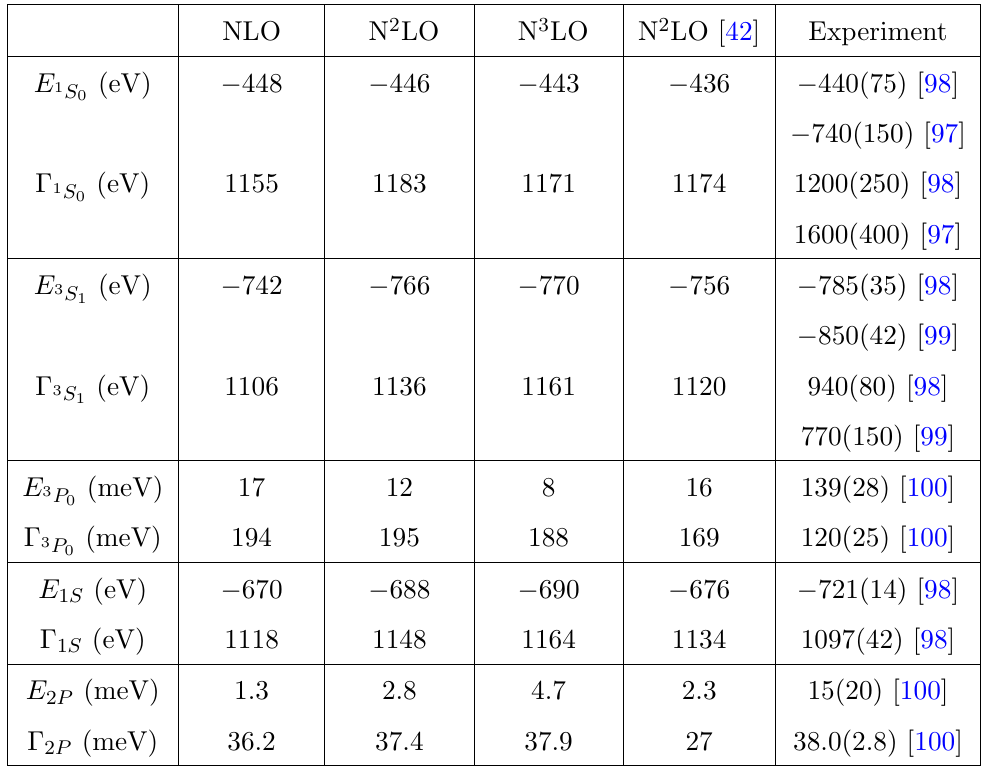
Table 4 . Hadronic shifts and broadenings in hyper(cid:12)ne states of (cid:22) p H for the chiral potentials with R = 0 : 9 fm. For comparison N 2 LO predictions of our previous chiral potential are included, based on the cuto(cid:11) combination ((cid:3), ~(cid:3)) = (450,500) MeV [42]. The experimental information is taken from refs.